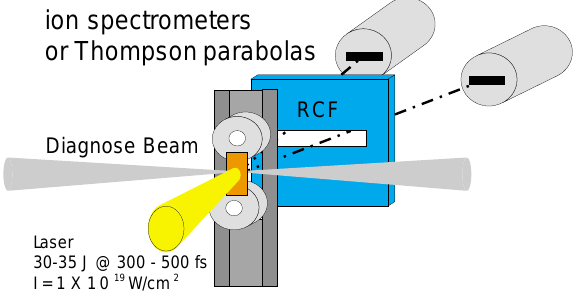
FIG. 1. (Color) Experimental setup. The freestanding target is irradiated at normal incidence. A slit in the radiochromic film (RCF) gives a line of sight for the particle